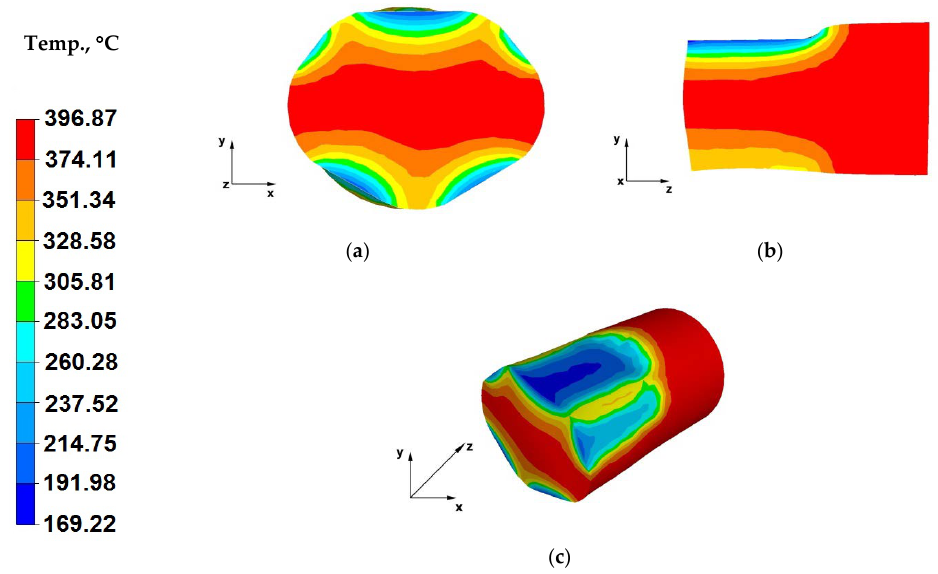
Figure 11. ( a ) Temperature distribution over the cross-section of an AZ91 alloy forging deformed within the first pass, with a relative reduction of 25%, in trapezoid-rhombic dies; ( b ) Temperature distribution over the longitudinal section of an AZ91 alloy forging deformed within the first pass, with a relative reduction of 25%, in trapezoid-rhombic dies; ( c ) Axonometric view of the temperature distribution over the surface of an AZ91 alloy forged within the first forging pass, with a relative reduction of 25%, in trapezoid-rhombic dies.